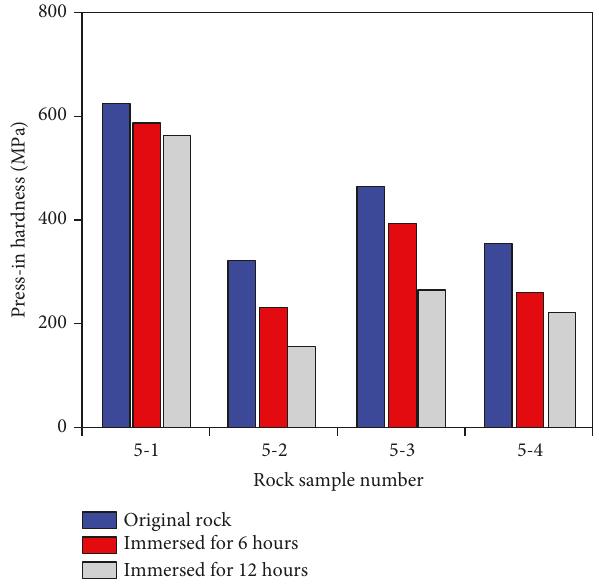
Figure 5: Hardness change with drilling fl uid